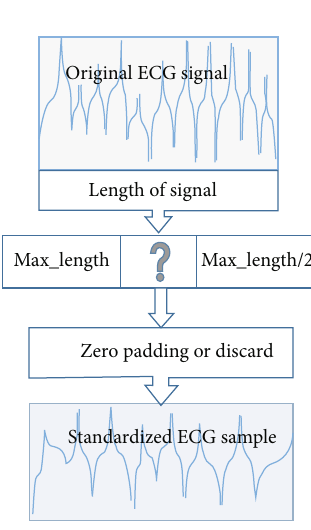
Figure 2: Examples of ECG waveforms.